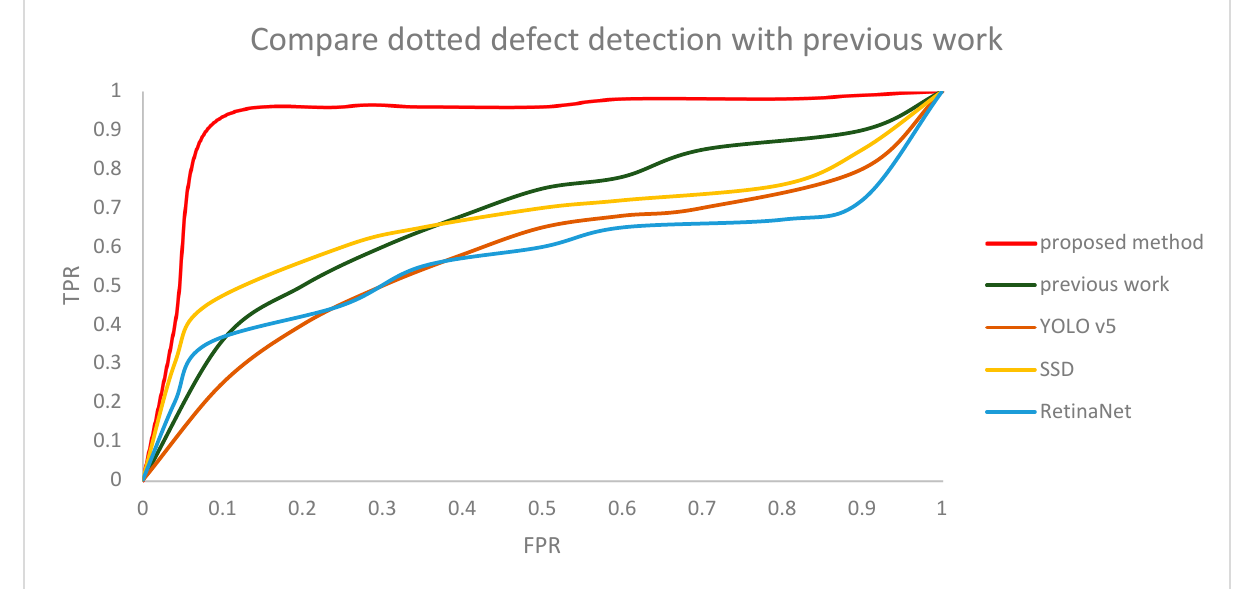
Figure 16. ROC curve for comparing dotted defect detection using CNN with previous work.